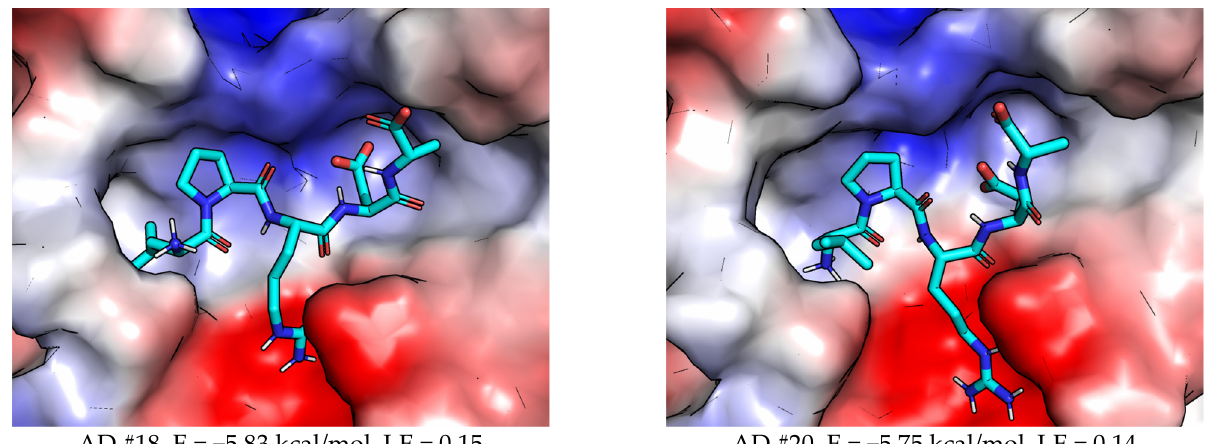
Figure 3. The initial LPRDA–SrtA complex geometries used for MD study. The scores (E) for either ADV or AD are provided for the best energy complex. The ligand efficiency metrics (LE) is calculated as LE = − E/NH, where NH—the number of heavy atoms of the ligand (for LPRDA NH = 40).